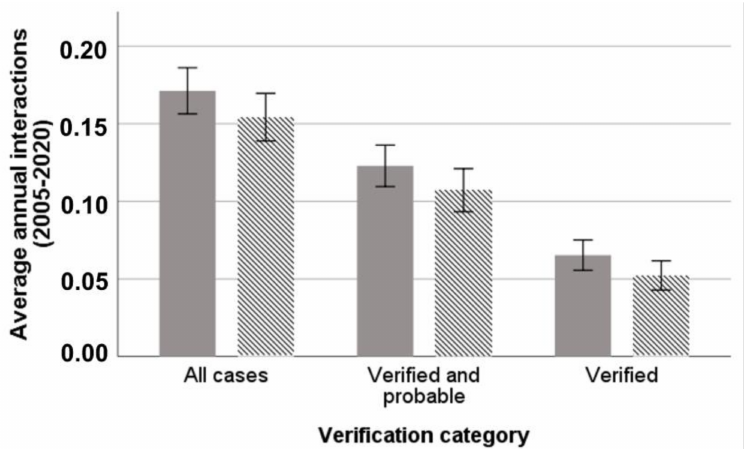
Figure 2. Average annual rate of dog interactions per hunter in the study area for the period 2005– 2020 for each verification class. Error bars represent ± 1 confidence intervals. Solid bars represent number of dogs and dashed bars represent number of